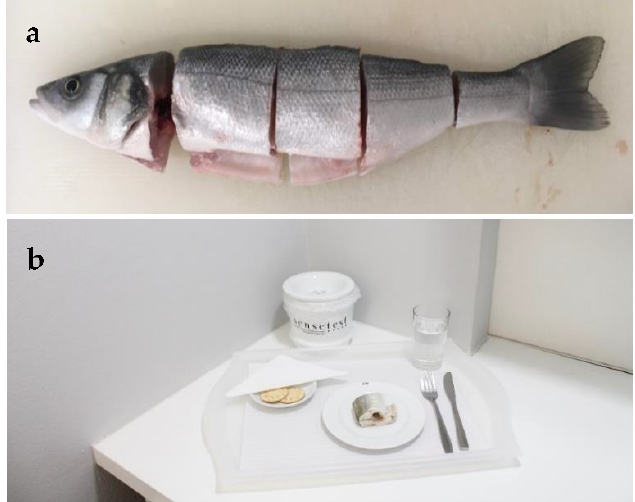
Figure 1. ( a ) Fresh sea bass descaled, gutted and sliced; ( b ) Individual slices served to participants after steam cooking wrapped in micro ‐ perforated aluminium foil, presented in preheated white porcelain plates with a random three ‐ digit code.